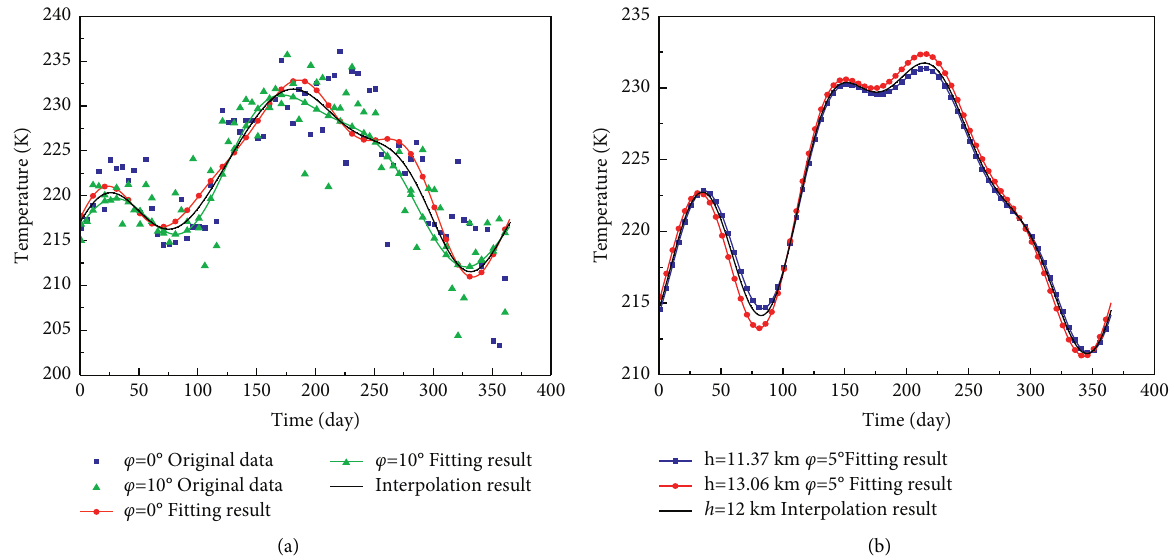
Figure 2: Temperature model fitting curves. (a) Temperature variation with time and latitude at the same altitude; (b) temperature variation with time and altitude at the same